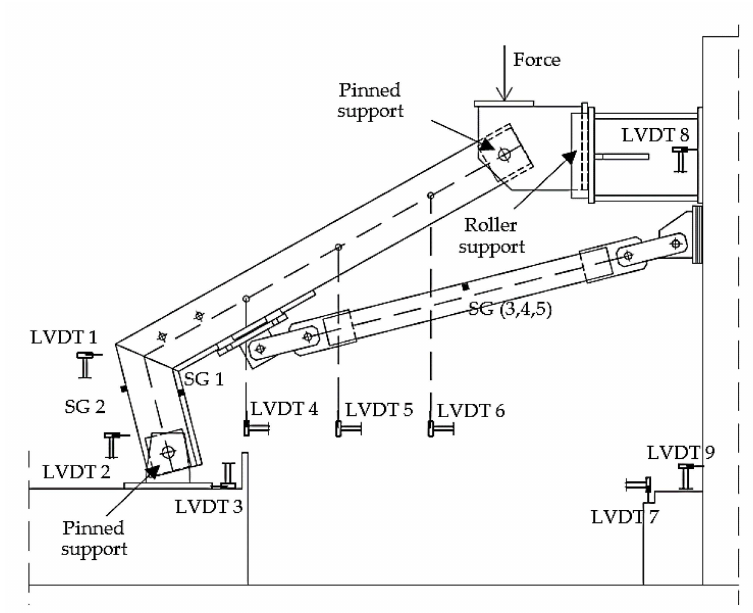
Figure 6. Test set-up and measuring